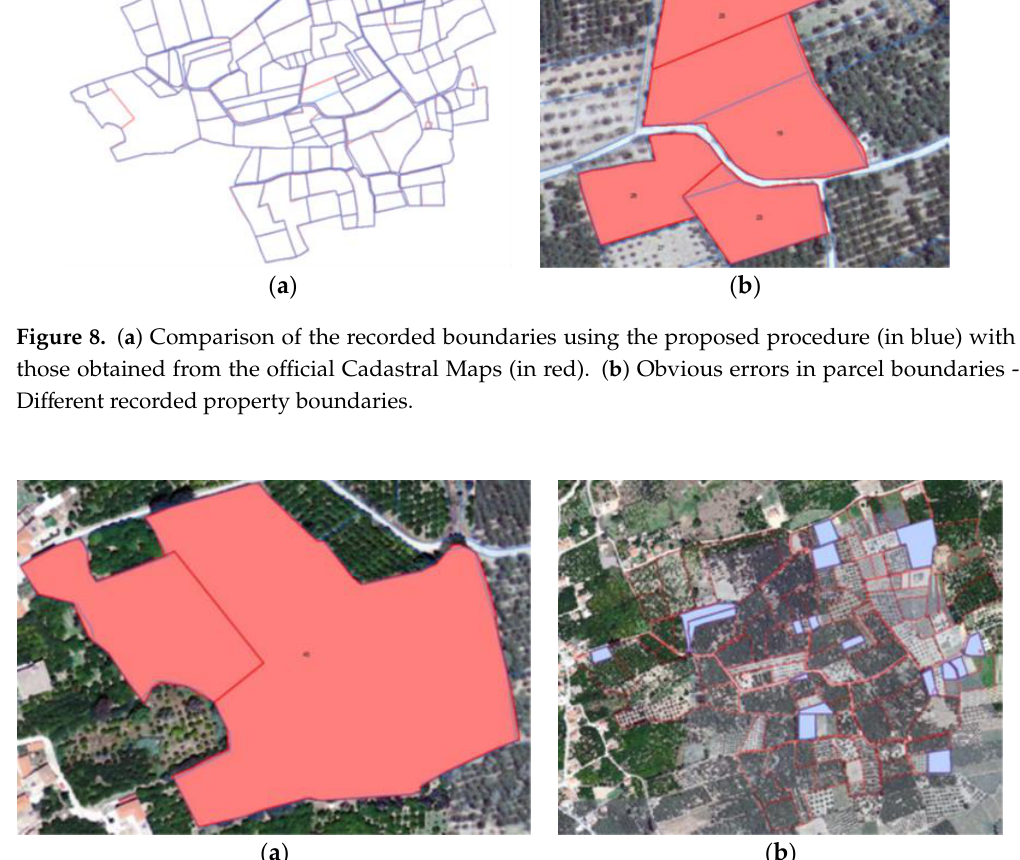
Figure 9. ( a ) Obvious errors in parcel boundaries – The land parcel is presented as two land parcels. ( b ) Land parcels that are not within the value of the “acceptable tolerance” area.